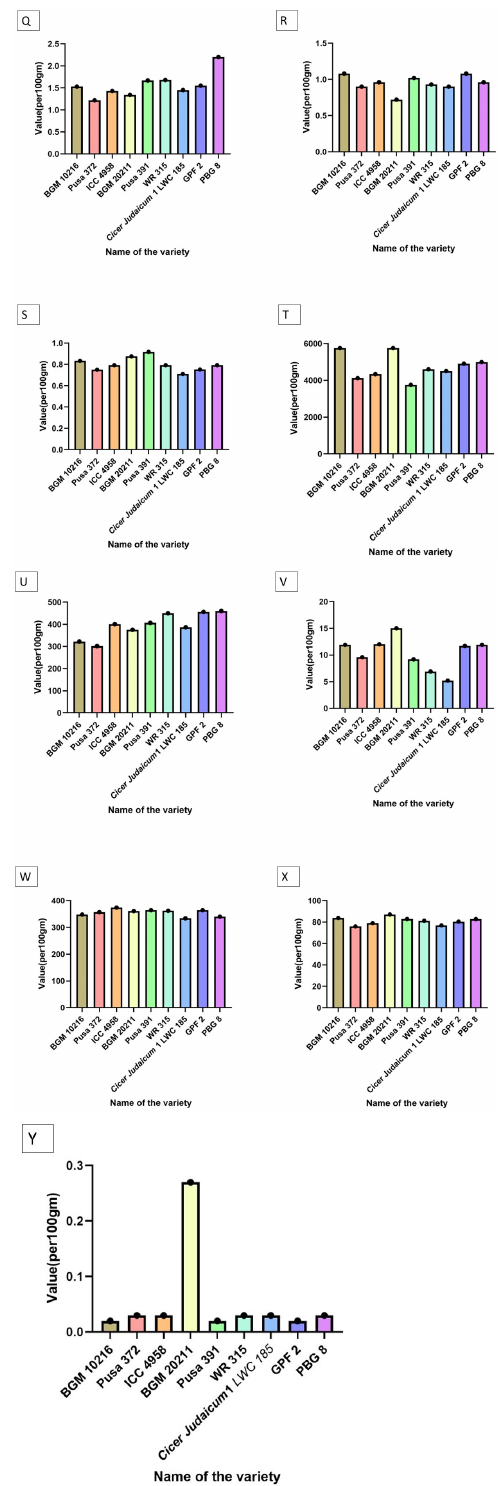
Figure 4. Biochemical tests of nine chickpea varieties ( A ) Crude Fiber content, ( B ) Crude protein content, ( C ) Total ash content ( D ) Carbohydrate content ( E ) Crude Lipid—Fat content ( F ) Methionine content ( G ) Arginine content ( H ) Lysine content ( I ) Cysteine content ( J ) Saturated fatty acids content ( K ) Polyunsaturated fatty acids content ( L ) Riboflavin content ( M ) Niacin content ( N ) Thiamin content ( O ) Folate content ( P ) β —carotene content ( Q ) Phenolic content ( R ) Flavonoid content ( S ) Omega 6: Omega 3 content ( T ) Antioxidant activity content ( U ) Lectin and hemagglutination activity ( V ) Uric acid content ( W ) Energy value content ( X ) Protein bioavailability ( Y ) Phytic acid content.